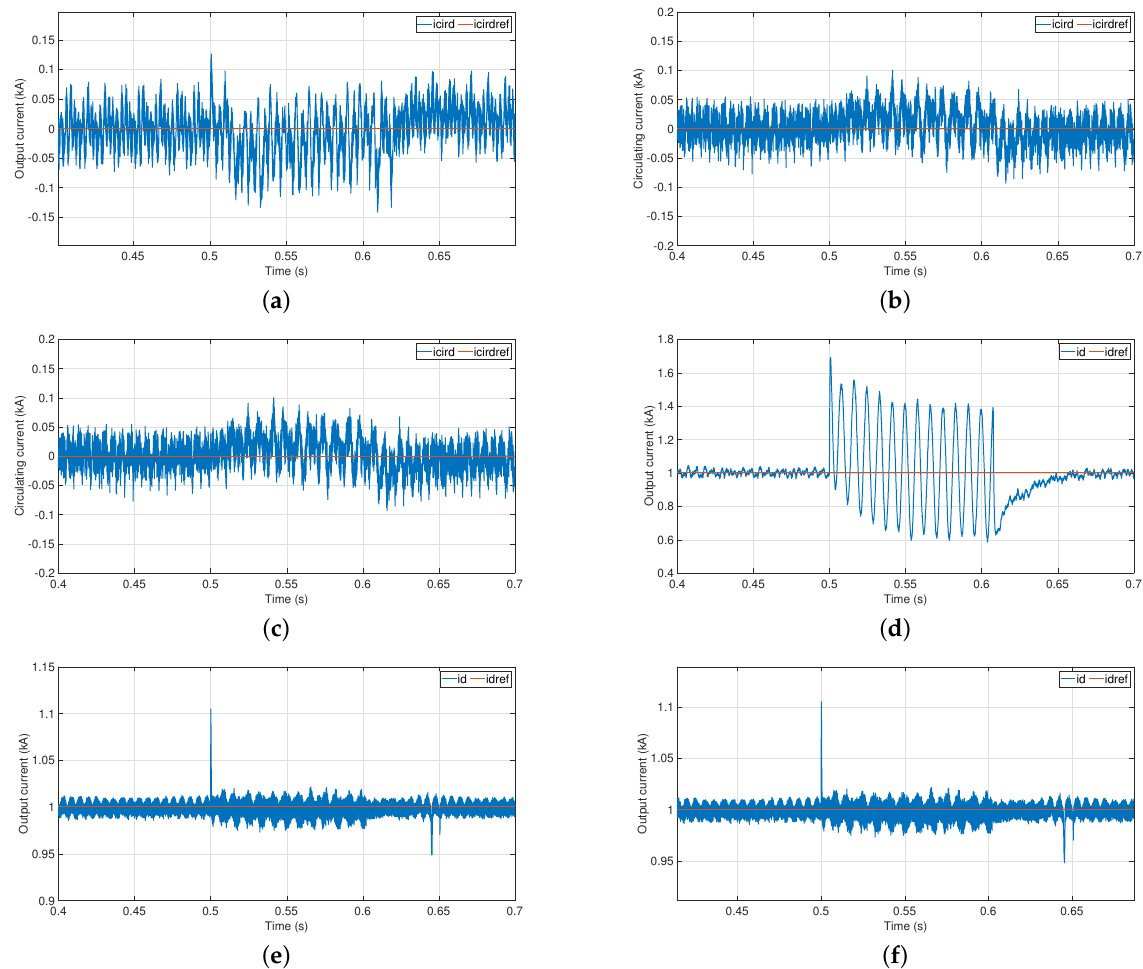
Figure 12. Circulating currents in d-axis: ( a ) PI control, ( b ) SMC, ( c ) proposed method; the output current in d-axis: ( d ) PI control, ( e ) SMC, ( f ) proposed